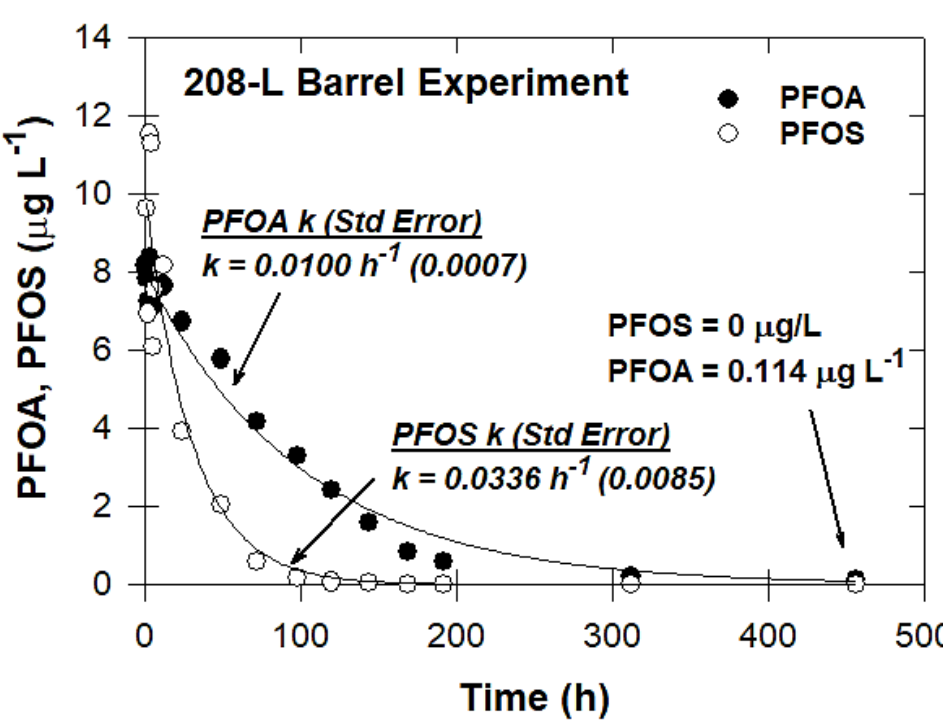
Figure 10. Temporal changes in PFOA and PFOS concentrations in 208 L barrel pilot-scale experi- ment.